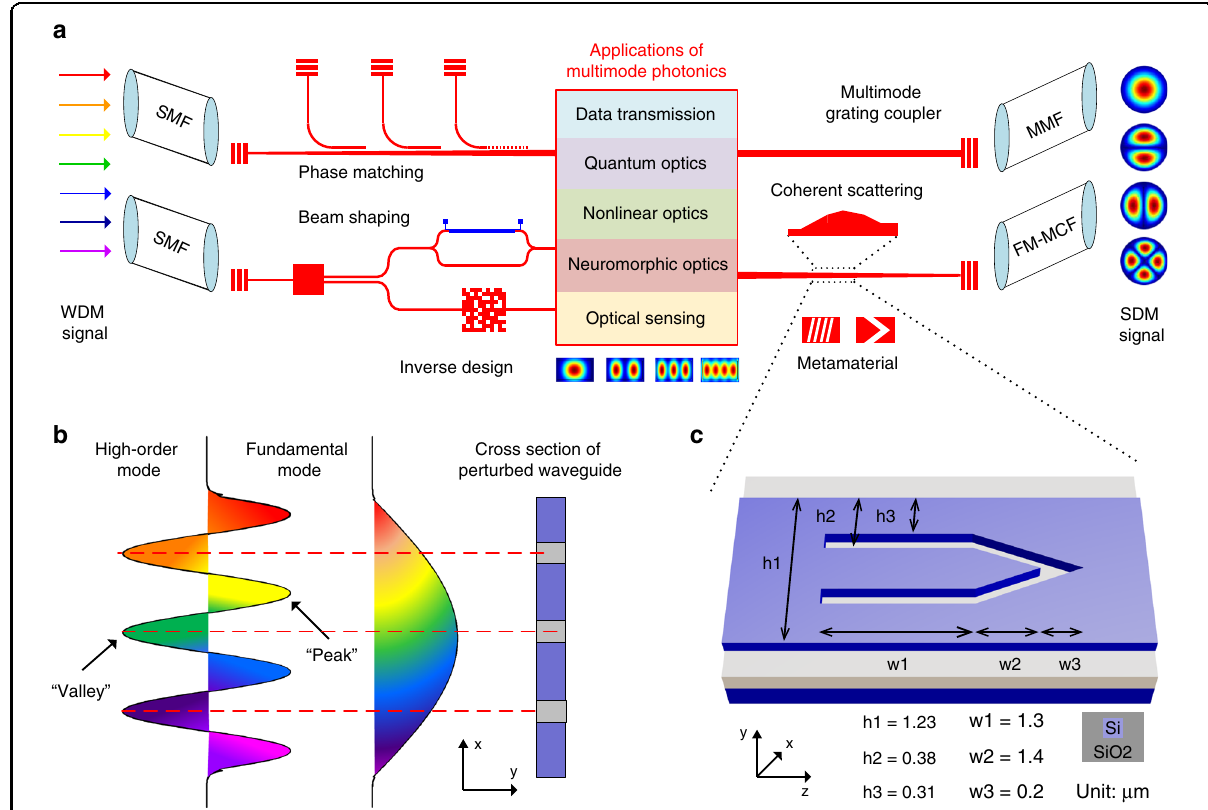
Fig. 1 Integrated multimode photonics and metamaterial building block. a On-chip mode manipulation techniques and multimode photonic application scenarios. WDM wavelength-division multiplexing, SMF single-mode fi ber, MMF multimode fi ber, FM-MCF few-mode multicore fi ber, SDM space-division multiplexing. b Dielectric perturbations are located at the “ peaks ” or “ valleys ” in the transverse mode pro fi le of high-order mode to maximize the mode overlap integral. c Schematic view of the metamaterial TE 0 -TE 2 building block (BB), exploiting fully etched dielectric slots on a silicon